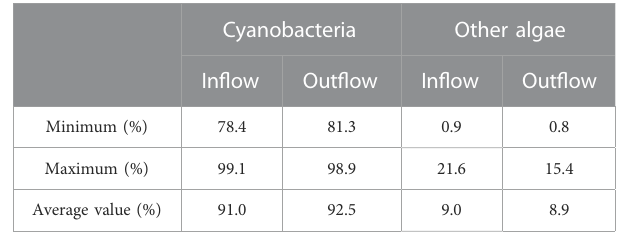
Data are from the microscopic examination results.